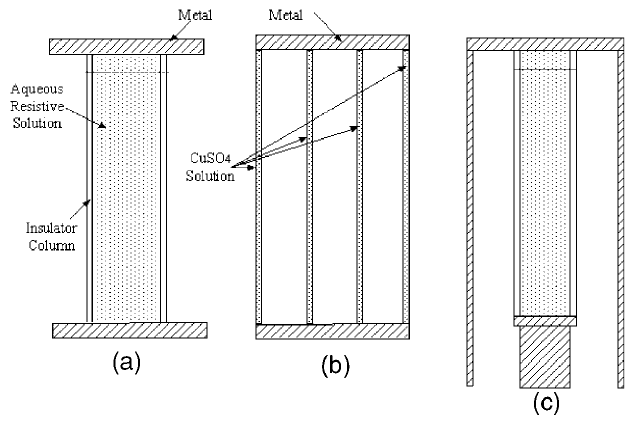
FIG. 1. Water load type: (a) balanced water load; (b) two tube water load; (c) coaxial water